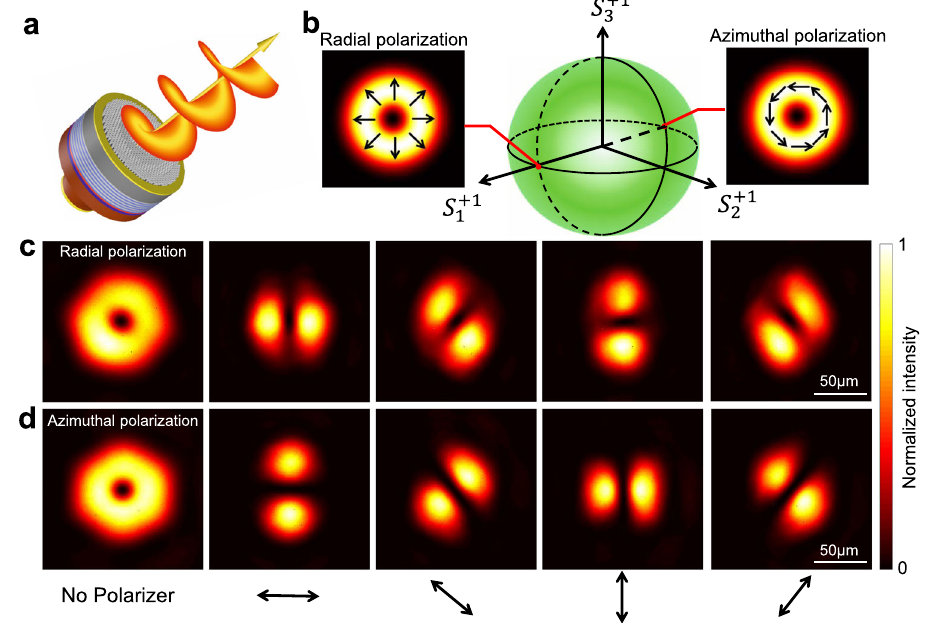
Fig. 5 | On-chip manipulation of the polarization states of VCSELs. a Schematic showing a metasurface integrated VCSEL that functions as a vector vortex laser. b As a proof ofconcept, twovector lasers with radical and azimuthal polarizations located on different positions of the HOPS are designed, respectively. The